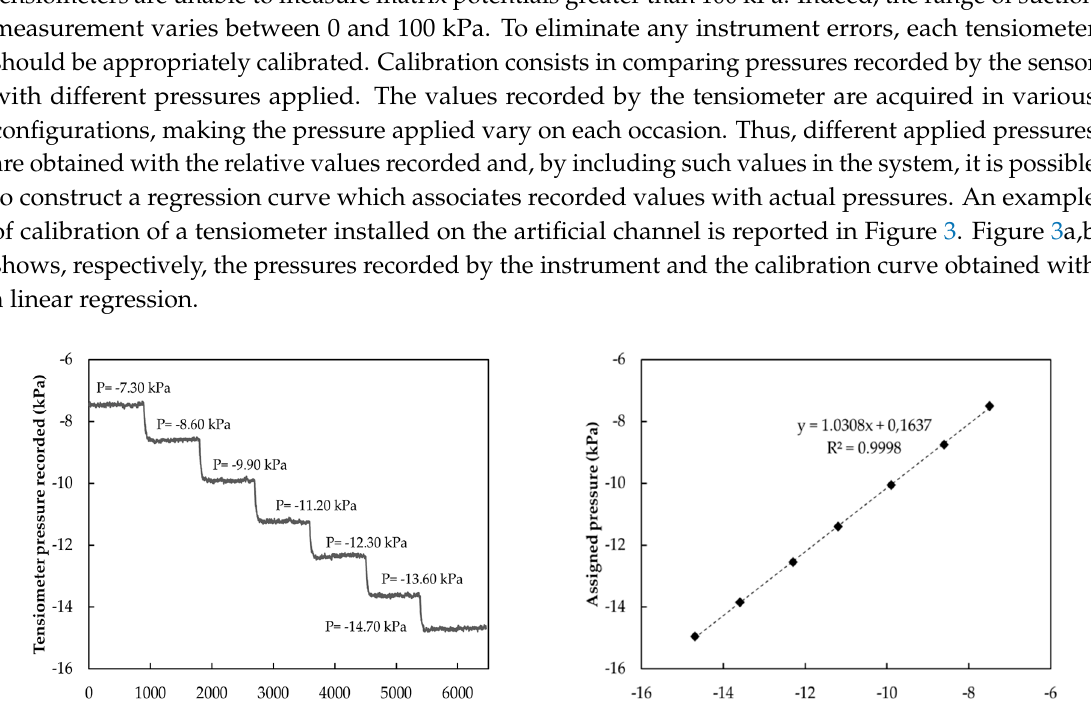
(b) Figure 4. Example of calibration of a pressure transducer:( a ) the graph shows the recorded response, in terms of pressure values, of the device at the various pressures applied; and ( b ) the graph shows the calibration curve of the transducer used.